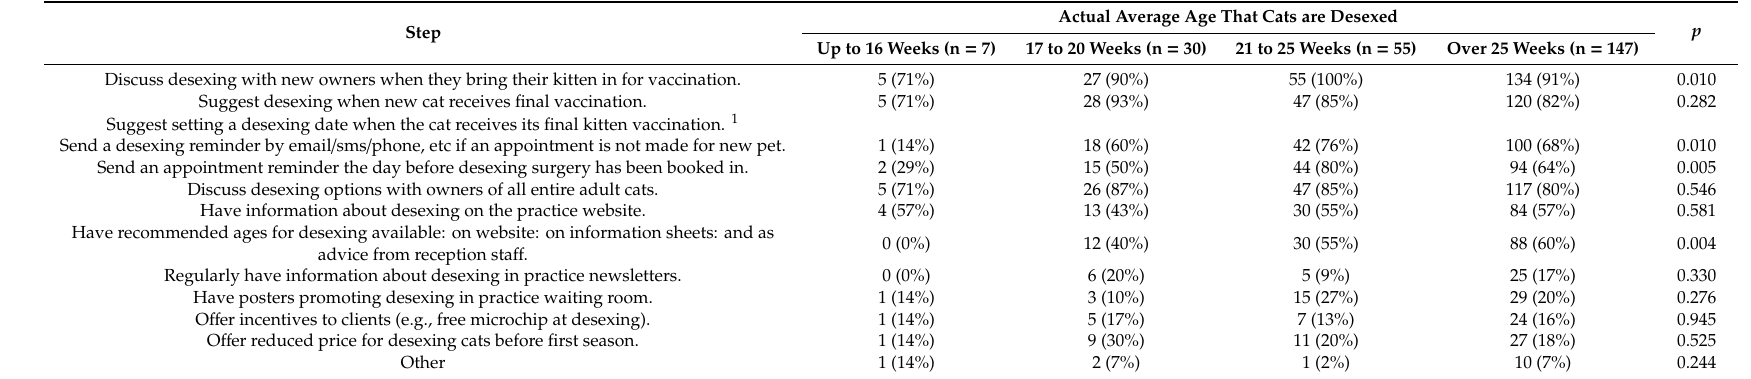
Table 6. Percentages of 239 Queensland veterinary practices that used various steps to promote desexing of cats by actual average ages at which cats were desexed. Actual Average Age That Cats are Desexed p Step Up to 16 Weeks (n = 7) 17 to 20 Weeks (n = 30) 21 to 25 Weeks (n = 55) Over 25 Weeks (n = 147) Discuss desexing with new owners when they bring their kitten in for vaccination. 5 (71%) 27 (90%)